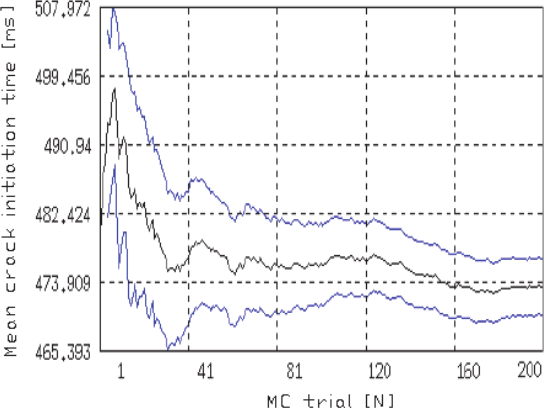
Figure 10: Mean of the crack init. time [ms] vs. MC trial.